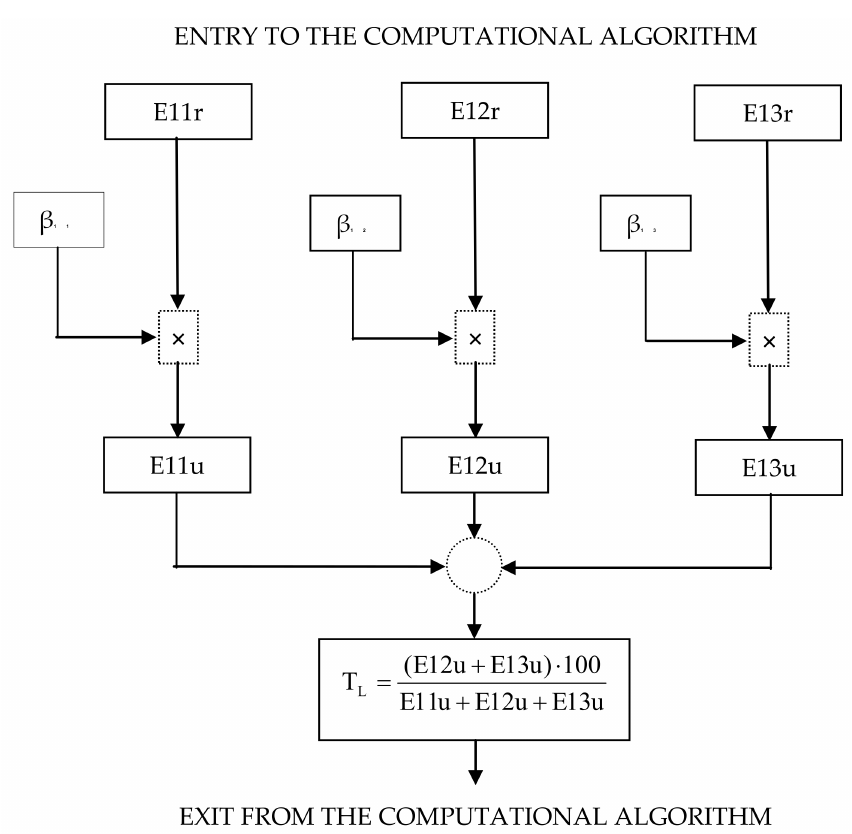
Figure 2. Algorithm to calculate the technological index level (T L ), where E11r (man-h/ref. unit): recorded human labor; E12r (kWh/ref. unit): recorded machine/tractor work; E13r (kWh/ref. unit): recorded energy of electrically powered devices; β 11 (MJ/man-h): energy utilization coefficient for human labor; β 12 (MJ/kWh): energy utilization coefficient for machine/tractor work; β 13 (MJ/kWh): energy utilization coefficient for a device driven by an electric motor; E11u (MJ/ref. unit): usable human energy input; E12u (MJ/ref. unit): usable machine/tractor work energy input; E13u (MJ/ref. unit): usable energy input of electrical equipment; and ref. unit: reference